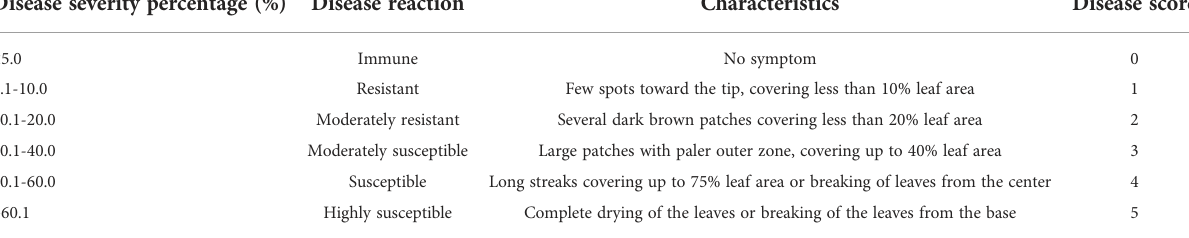
TABLE 1 Stemphylium leaf blight interactions and phenotypic classes used for the evaluation of onion genotypes (Pathak et al., 1986). Disease severity percentage (%) Disease